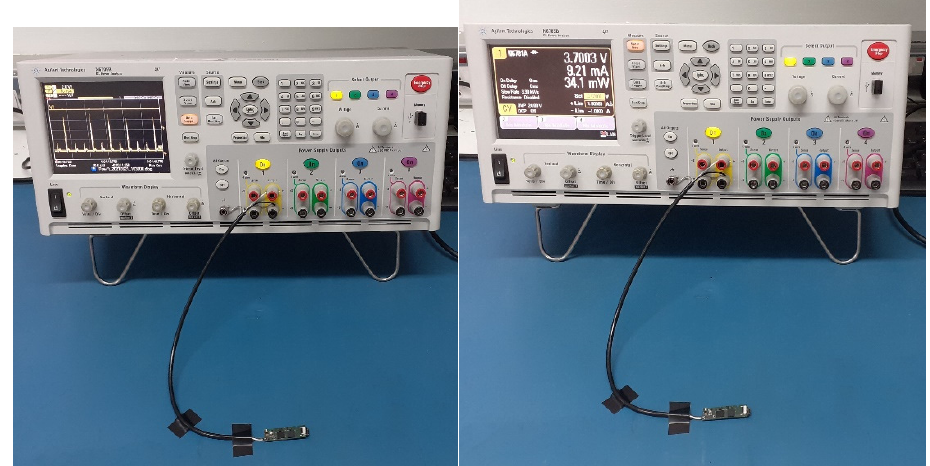
Figure 17. Power consumption measurement of battery lifetime using a DC power analyser. The power consumption of AquaBit is very low (~1 mA) for most of the time, since the unit is in sleep mode and it goes to higher values during the sampling, as is shown in Figure 18. The average of current and power consumptions are 1.6 mA and 5.7 mW.